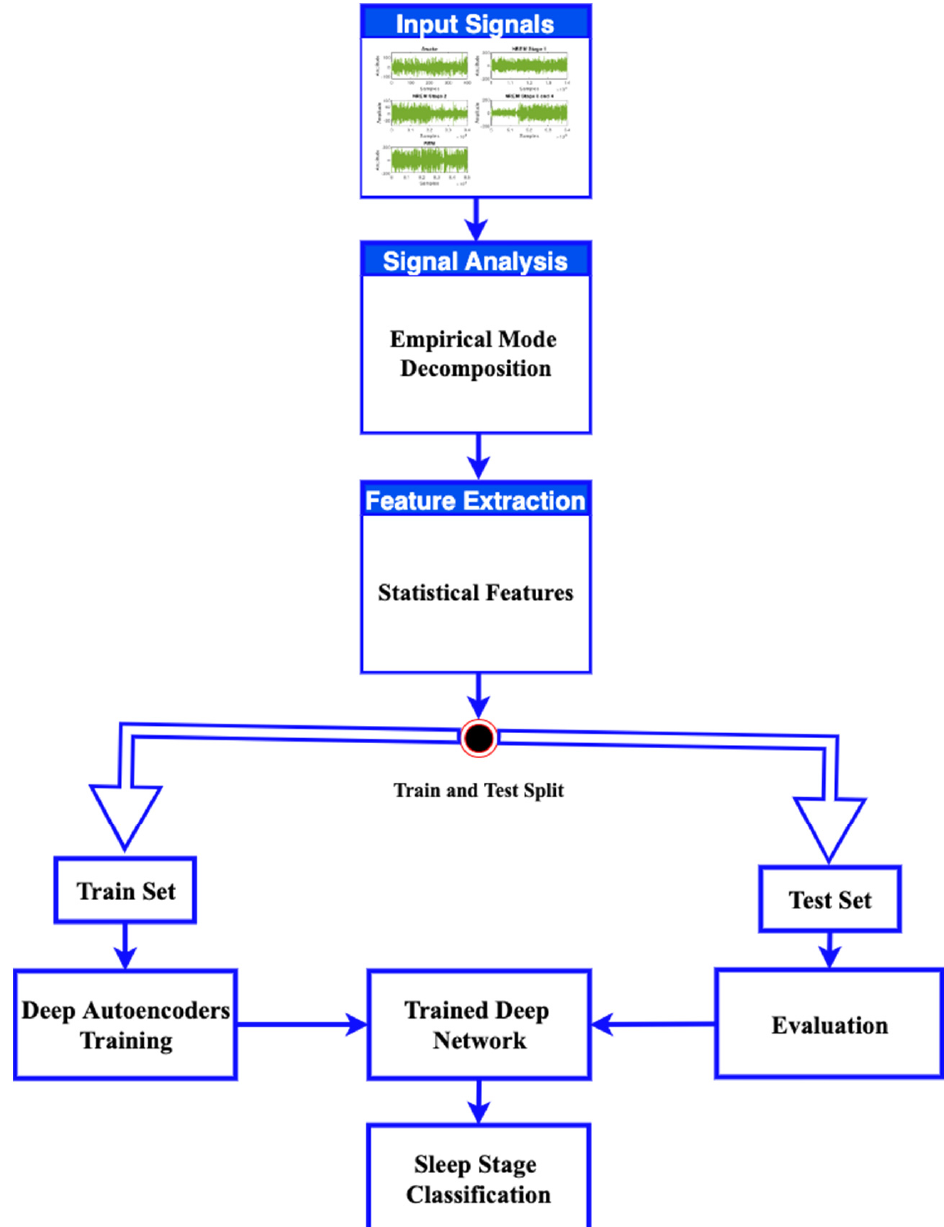
Figure 1. A block diagram of the proposed model. The obtained data were subjected to empirical mode decomposition (EMD). The EMD analyzes a signal by breaking it down without leaving the time domain. It is mostly used for signals that are natural and non-stationary. It filters out functions that are statistically unrelated to the original signal, which gives an impression of denoising the signal. These functions are known as intrinsic mode functions (IMFs). Obtaining IMFs from real-world signals is important because natural processes such as sleep have multiple events, and each of these events happens at specific time intervals. The decomposition of signals into subcomponents is helpful to analyze signals more easily and efficiently. For instance, feature extraction from each intrinsic mode function through a stacked autoencoder-based DNN is more meaningful as it can result in the generation of non-overlapping features. This type of data is evident in an EMD analysis but quite hidden in the Fourier domain or wavelet coefficients. For this reason, we preferred EMD for collecting useful data